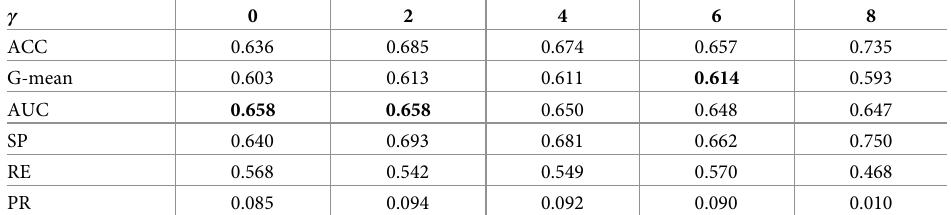
Table 12. Comparative analysis of CSDNN-FL versus γ using Oklahoma Full dataset. ACC, SP, PR, and RE repre- sents accuracy, specificity, precision, and recall, respectively. The highest G-mean and AUC values are denoted in bold. The parameter α is set as